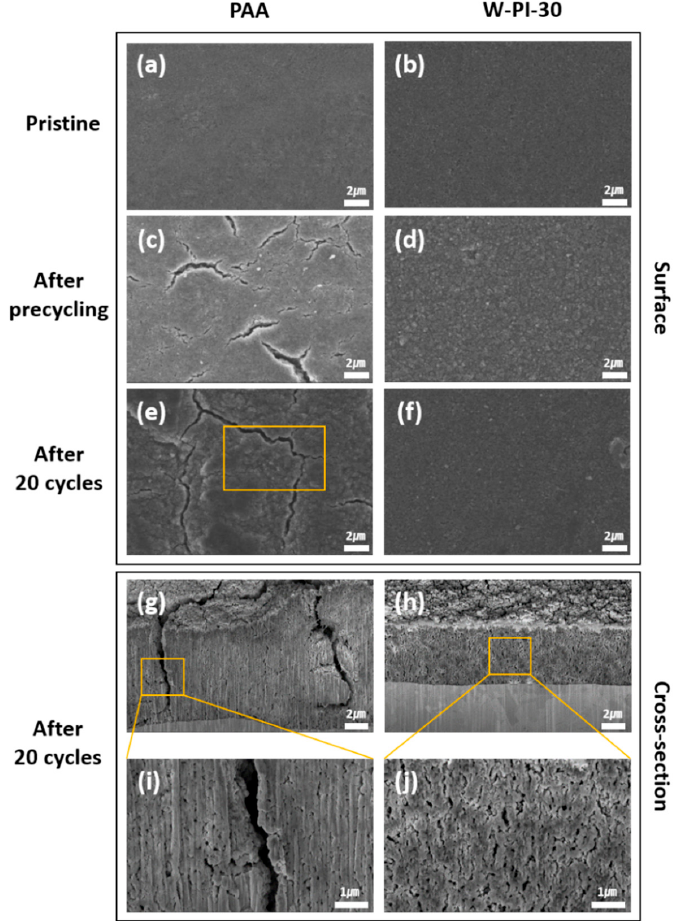
Figure 5. FE-SEM images of Si electrodes with PAA and W-PI-30 binders. ( a – f ) Surface morphology of Si electrodes before cycling, after precycling, and after 20 cycles (( a , c , e ) PAA and ( b , d , f ) W-PI-30). ( g – j ) Cross-sectional images of Si electrodes with PAA and W-PI-30 binders after 20